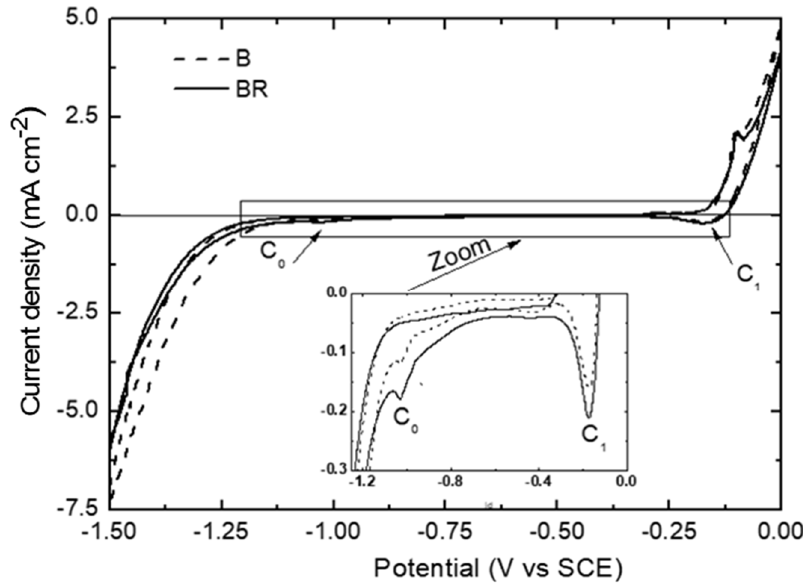
Figure 6. Cyclic voltammogram (from − 1.5 to 0 V vs SCE) in 3.5 wt.% NaCl at a 1 mV s − 1 scan rate for B and BR (annealed) samples.